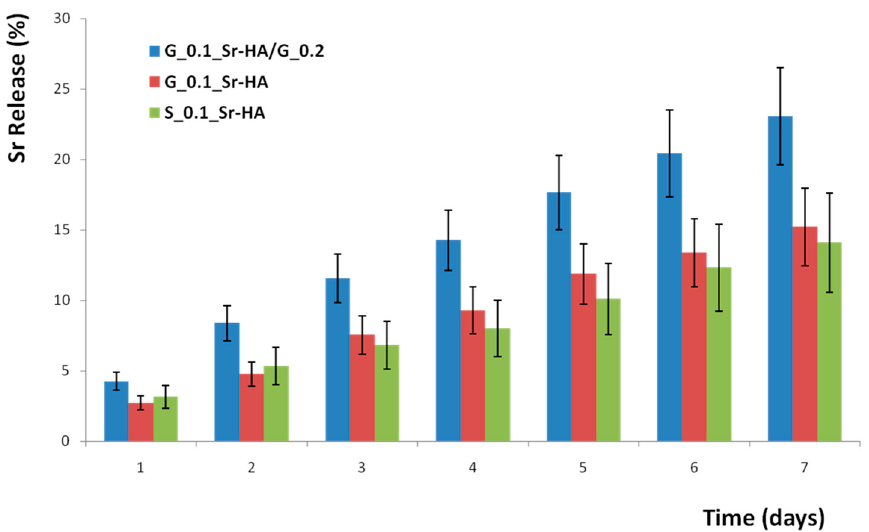
Figure 5. Strontium cumulative release from samples G_0.1_Sr-HA / G_0.2 (blue), G_0.1_Sr-HA (red) and S_0.1_Sr-HA (green) as a function of soaking time in NaCl 0,9% at 37 °C.